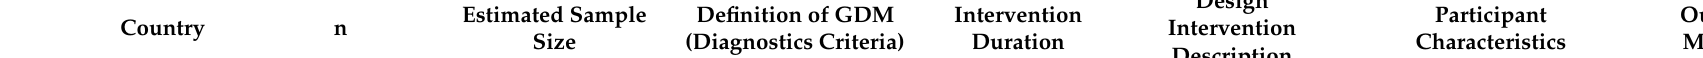
Table 1. Summary of RCTs investigating effect of nutritional supplement-based interventions on glycemic indices in GDM.